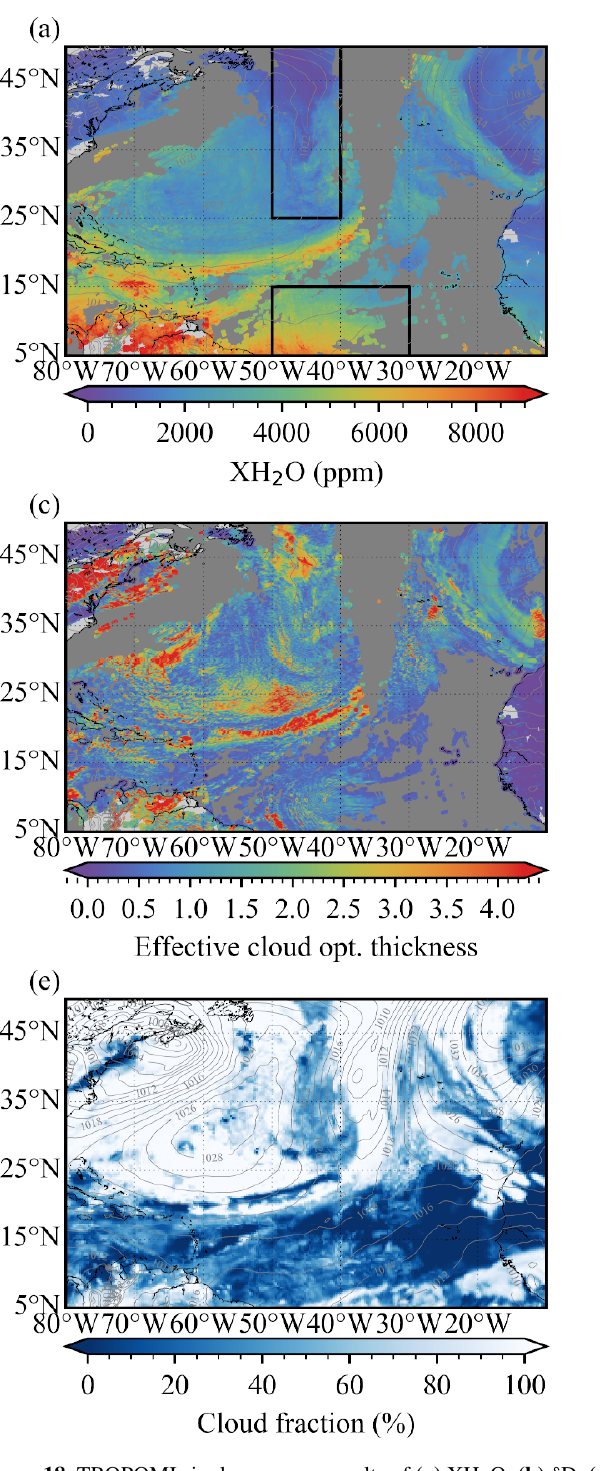
Figure 18. TROPOMI single-overpass results of (a) XH 2 O, (b) δ D, (c) retrieved effective cloud optical thickness and (d) column averaging kernel at the surface over the North Atlantic on 19 January 2020; (e) ERA5 cloud fraction and (f) ERA5 potential temperatures at 850hPa at 15:00UTC. The grey contours in all panels show ERA5 mean sea-level pressure at 15:00UTC with a contour line distance of 2hPa. The black contours in (f) show vertical winds at 500hPa at levels of 0.5Pas − 1 . The boxes in (a) and (b) mark the regions for which Rayleigh plots are depicted in Fig.